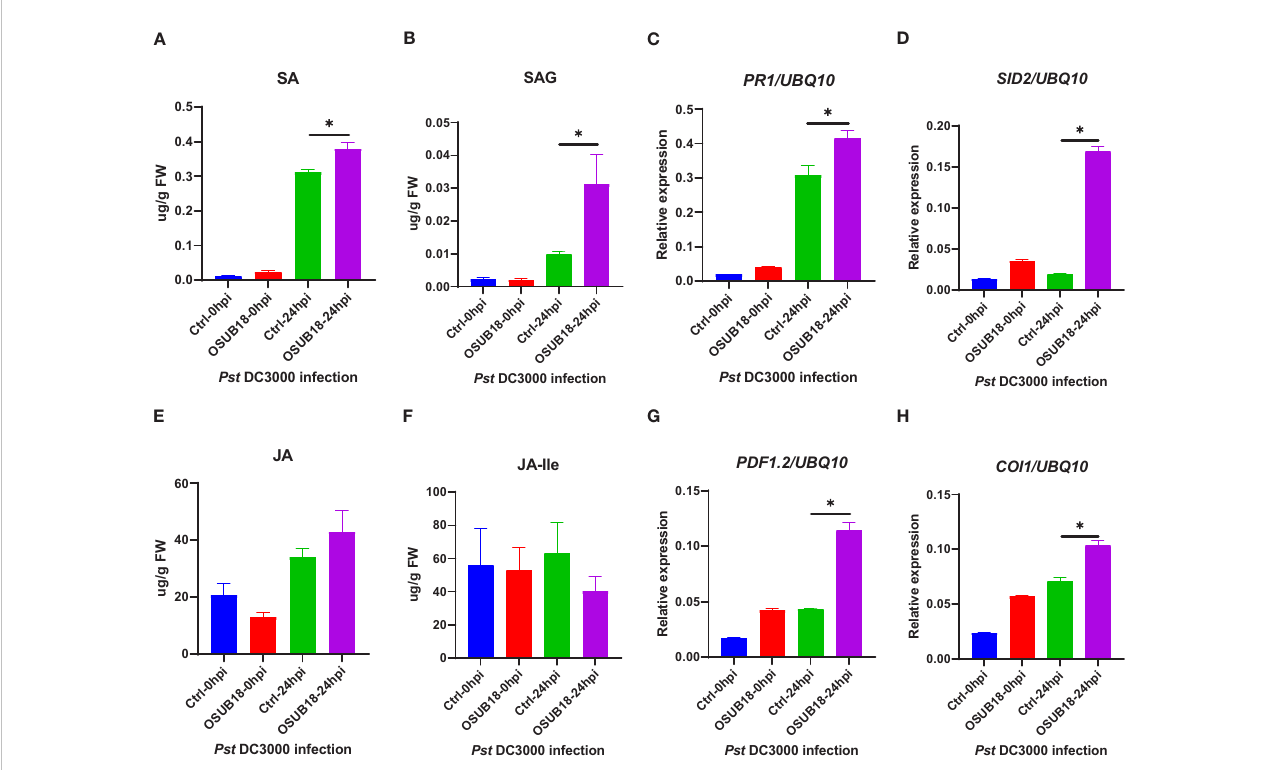
FIGURE 8 OSUB18 root drench treatment increased the SA and SA-related gene expression levels in A thaliana after the bacterial pathogen Pst DC3000 infection. (A) Free SA level. (B) Conjugated SA(SAG) level. (C) Relative gene expression of PR1 . (D) Relative gene expression of SID2 . (E) Free JA level. (F) Conjugated JA level. (G) Relative gene expression of PDF1.2 . (H) Relative gene expression of COI1 . Water or OSUB18-drenched plants were infected with Pst DC3000 by syringe injection. 0 or 24 hours later, the injected leaves were collected for phytohormone quanti fi cation and qRT-PCR assay. The UBQ10 gene was used